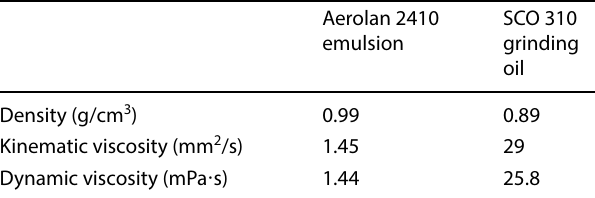
Table 2 Test matrix with varying rotational speeds and fluid quanti- ties Amount of fluid in ml (filling level